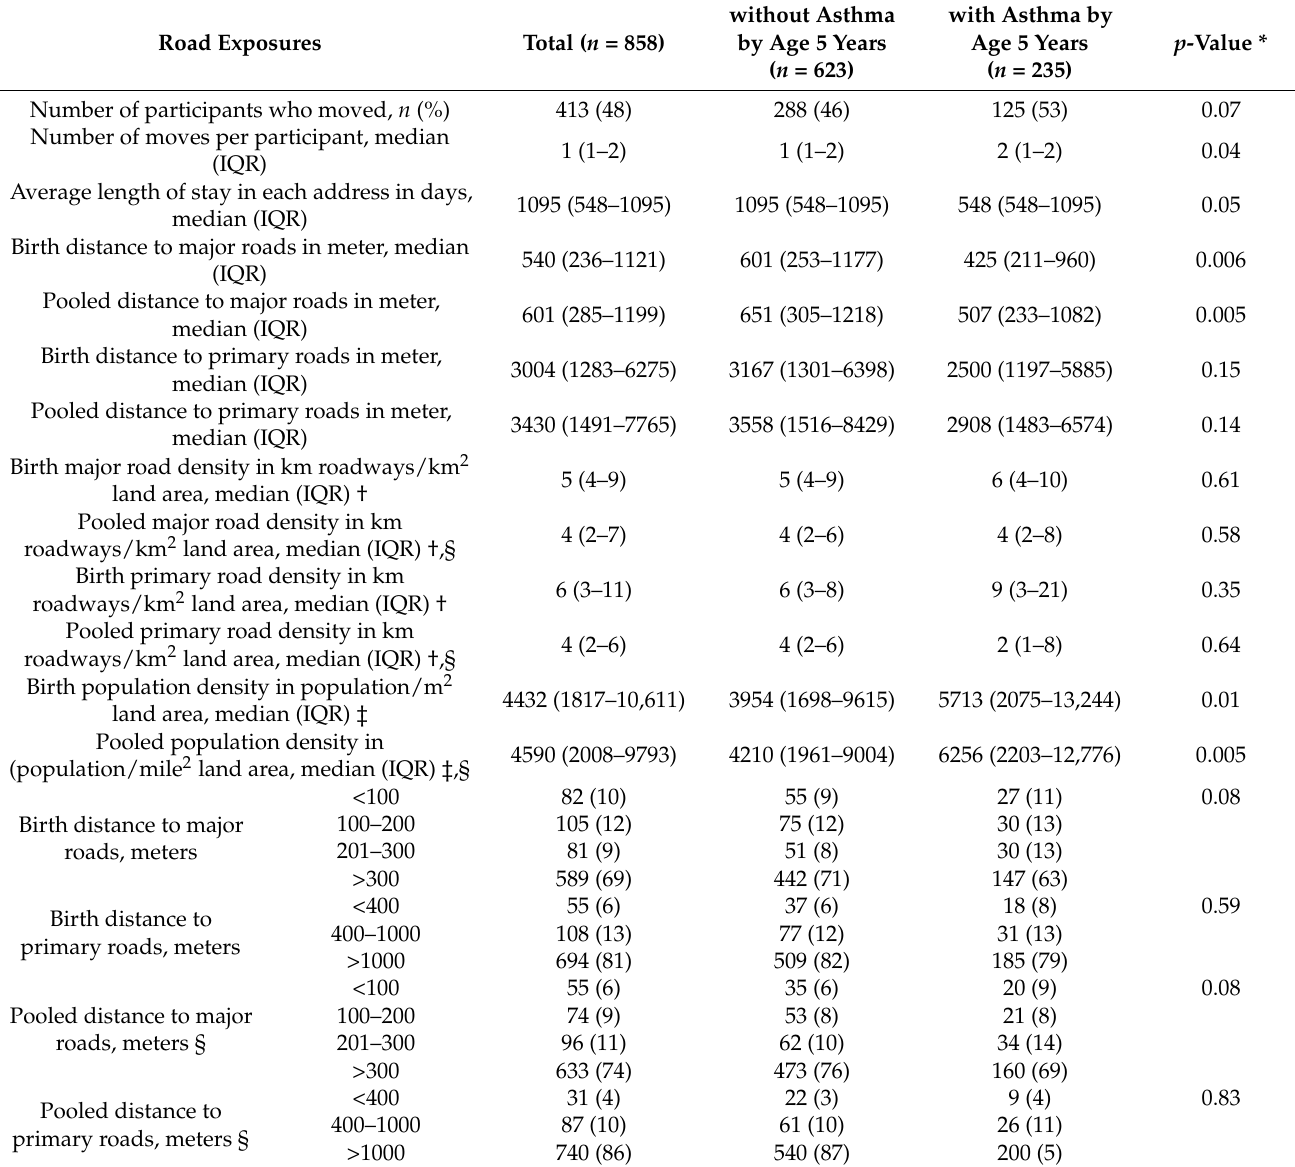
Table 4. Distribution of road exposures at birth and pooled road exposures by asthma status by age 5 years.